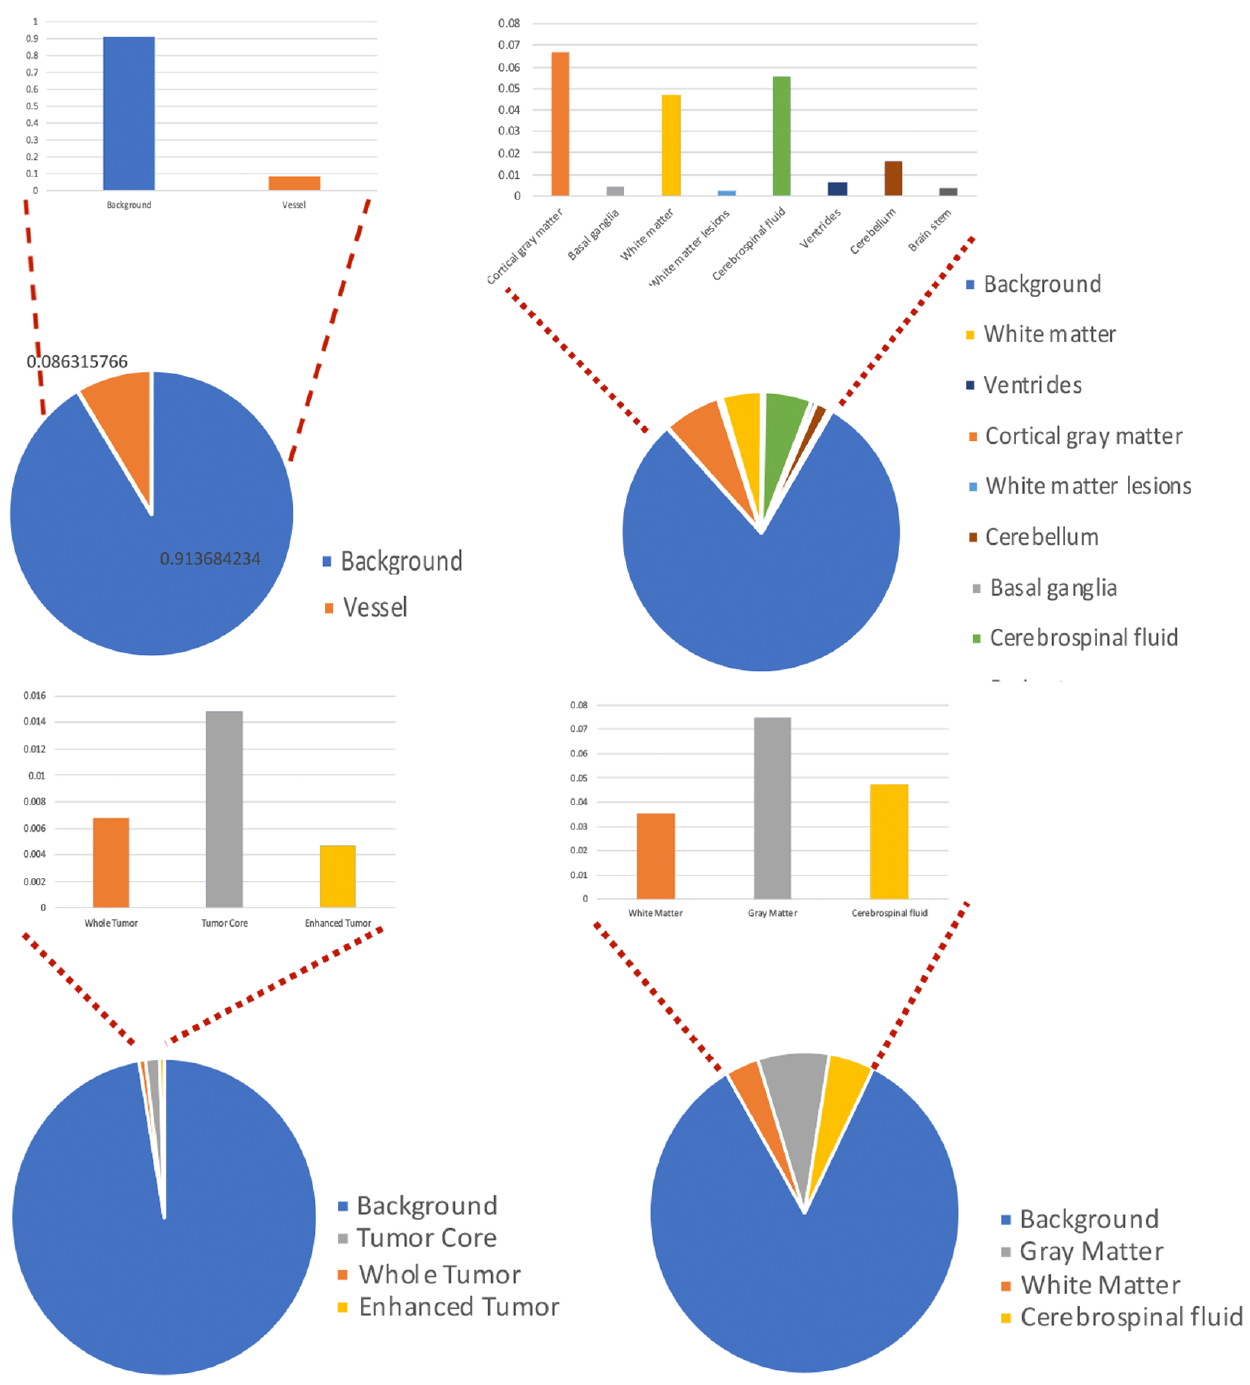
Figure 2. Class distribution of four